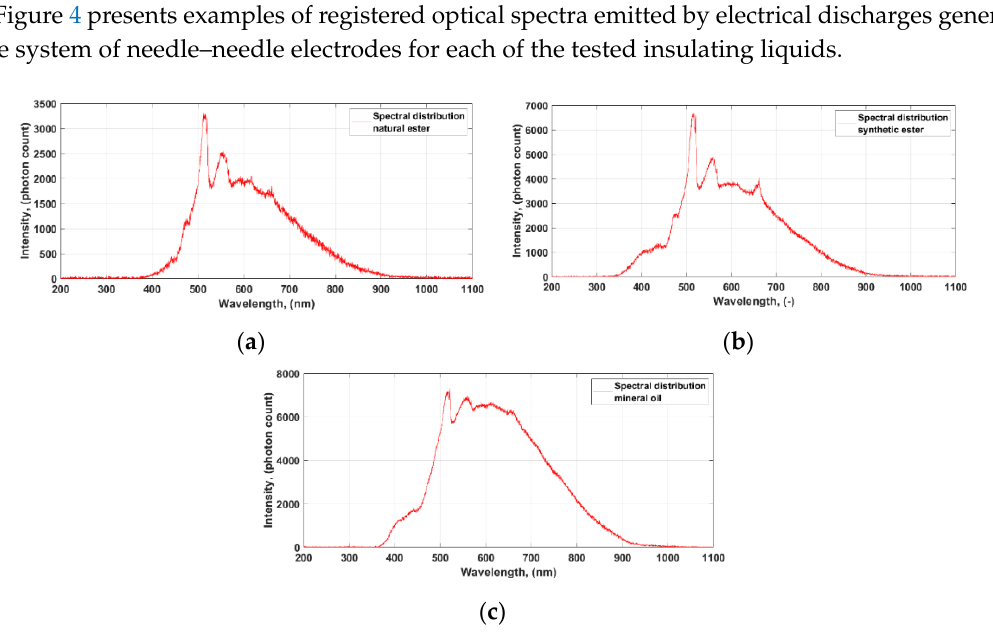
Figure 4. Example results of measurements generated on a needle–needle spark gap at 35 kV supply voltage for the following insulating liquids: Midel 1204 ( a ); Midel 7131 ( b ); and Mineral oil ( c ).